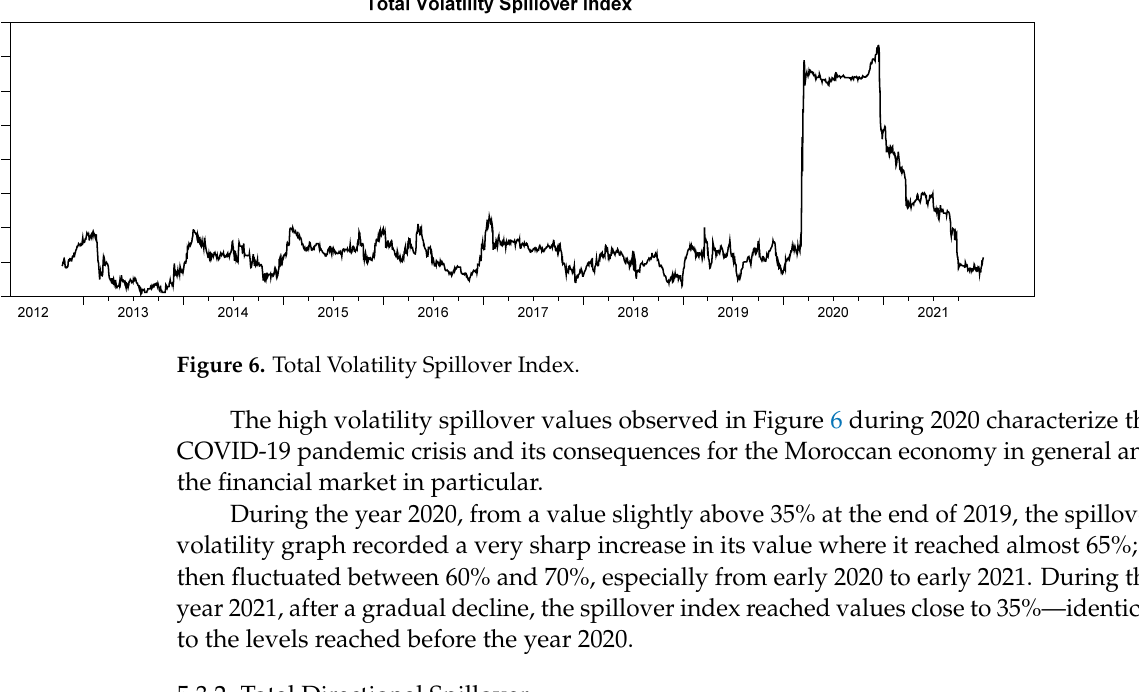
Figure 5. Daily Bank Volatility Index Percent.